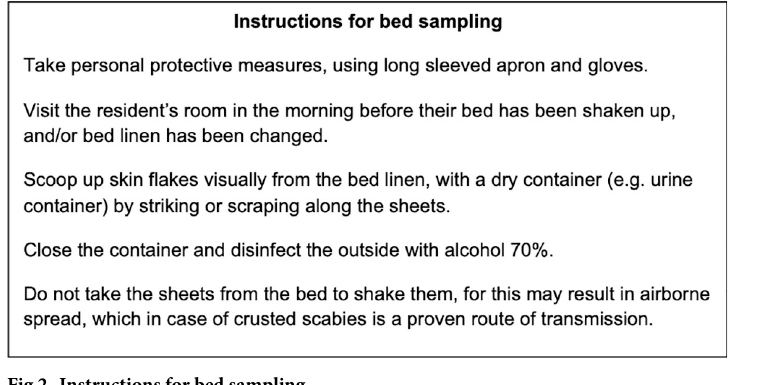
Fig 2. Instructions for bed